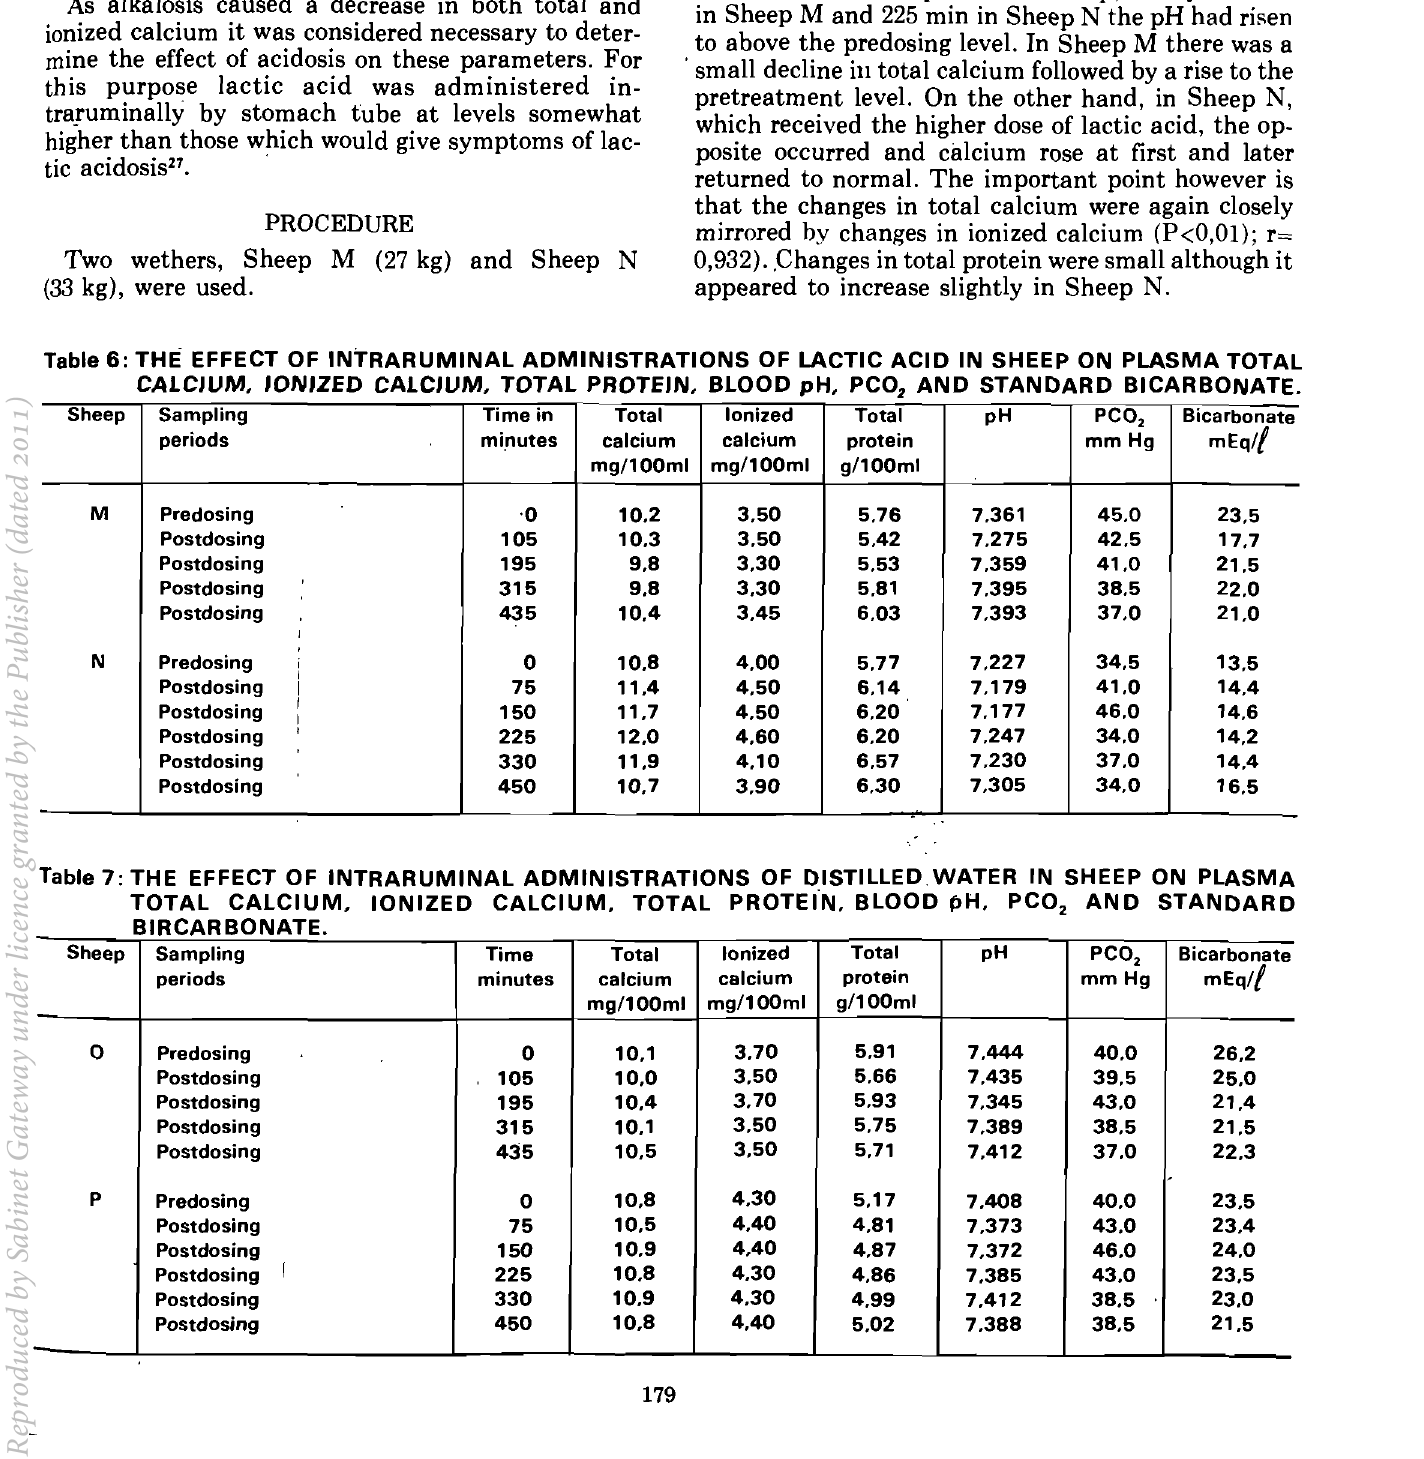
Table 6: THE EFFECT OF INTRARUMINAL ADMINISTRATIONS OF LACTIC ACID IN SHEEP ON PLASMA TOTAL CALCJUM, IONIZED CALCJUM, TOTAL PROTEIN, 8LOOD pH, PCOz AND STANDARD BICARBONATE. Sheep Sampling